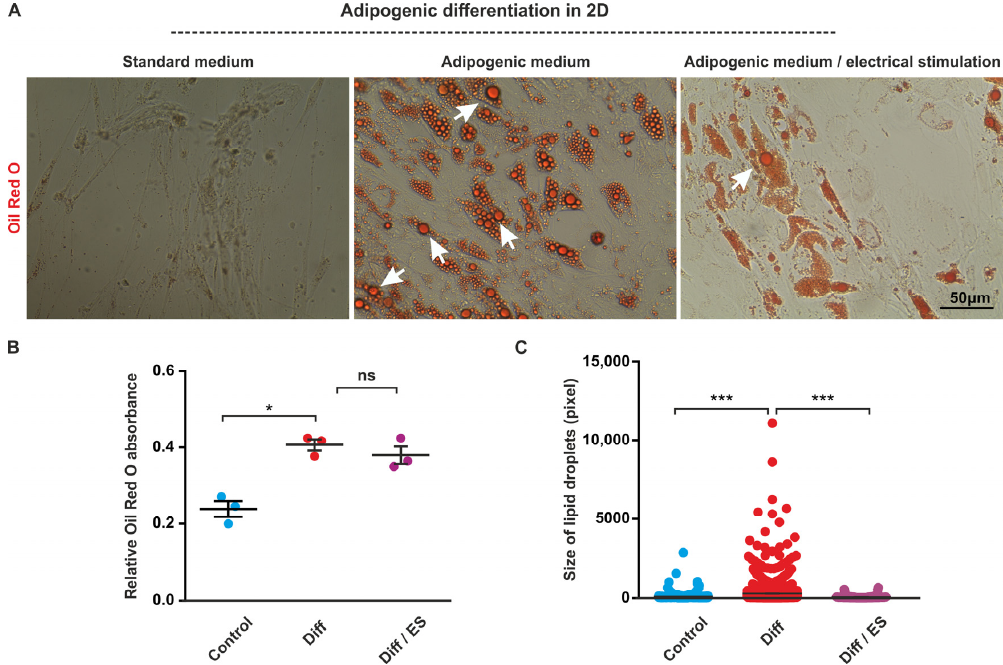
Figure 3. Electrical stimulation (ES) interferes with adipogenic di ff erentiation of adipose-derived stem cells (ASCs). ASCs were cultivated in adipogenic medium or standard medium for 21 days followed by staining of lipid droplets by Oil Red O, microscopy, and image analysis. ( A ) Microscopy revealed multiple large lipid droplets in cells in adipogenic medium without ES and only a few in cells exposed to ES. Scale bar: 50 µ m. ( B , C ) Image analysis revealed a slight but not significant decrease of Oil Red O absorbance and a highly significant decrease of the average size of the lipid droplets in cells cultivated under adipogenic conditions exposed to ES compared to cells in adipogenic medium without ES. Error bars: SEM. * p < 0.05, *** p < 0.0001. ns: not significant. Di ff : di ff